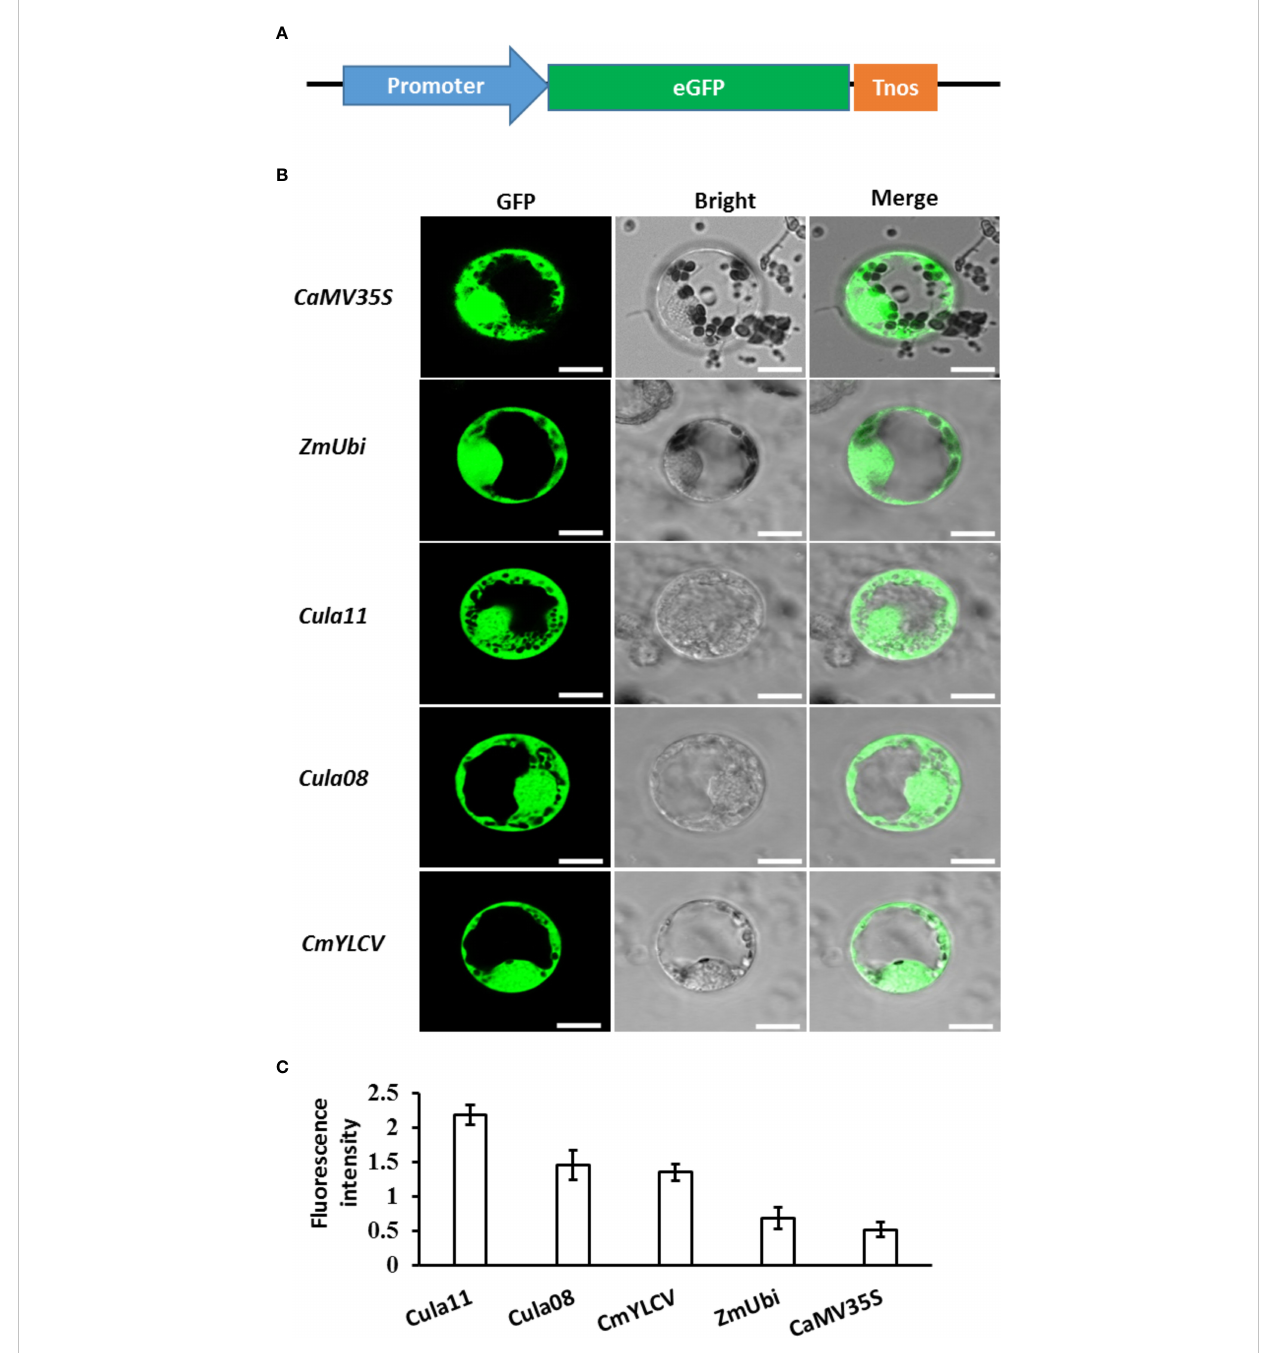
FIGURE 2 Activities of various promoters in Chinese fi r protoplasts. (A) Schematic representation of the vector used for protoplast transformation in Chinese fi r. (B) Represented Chinese fi r protoplasts transfected with the plasmid expressing GFP driven by various promoters. Scale bar: 10 m m. (C) Promoter activity assays. The fl uorescence of the positive protoplasts were measured using ImageJ, and the mean ± s.d for n=25 individual protoplasts for each sample were calculated. These experiments were repeated three